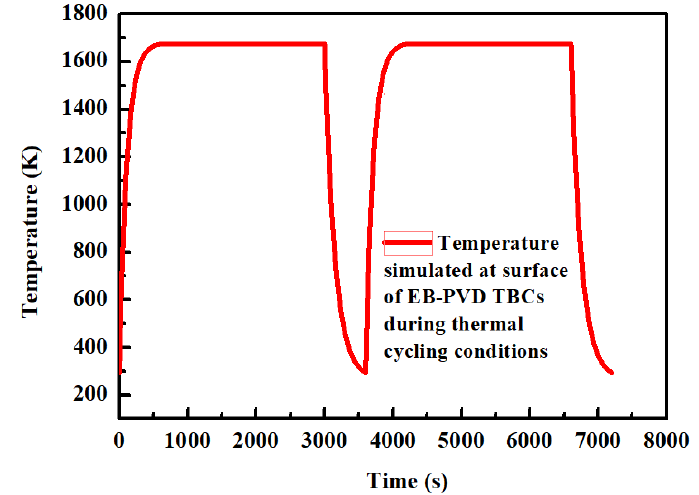
Figure 4. The pattern of surface temperature profile of EB-PVD TBCs (Two thermal cycles) [33]. The effect of high-temperature dwell time on erosion rate is discussed in Section 4, in which different erosion rates are calculated based on variation of the ratio of high- temperature dwell time over the total thermal cycle time, R t = t HIGH / t cycle . The holding time kindly reflects the thermal cycling characteristics. In the present study, two types of thermal cycling are represented by R t parameter for EB-PVD TBCs erosion. For the